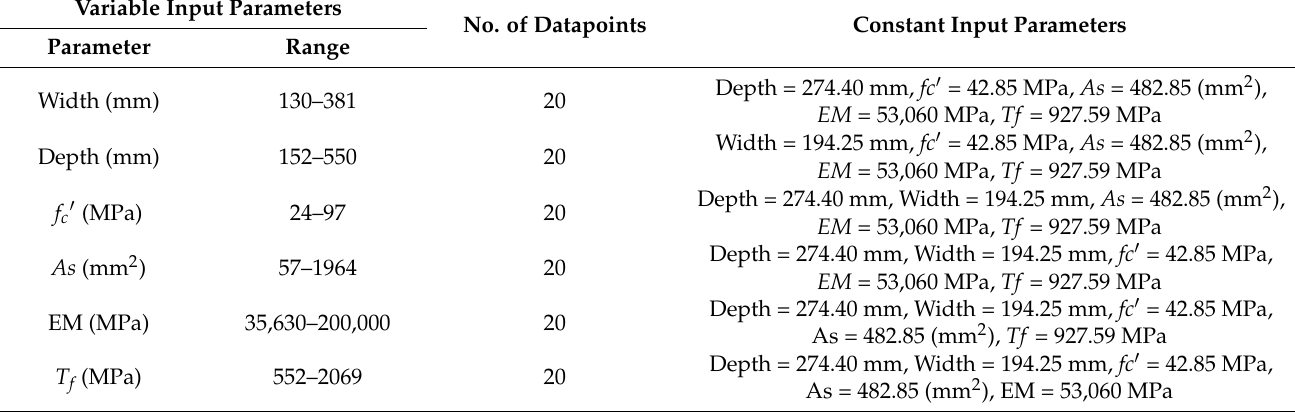
Table 5. Simulated dataset for parametric and sensitivity